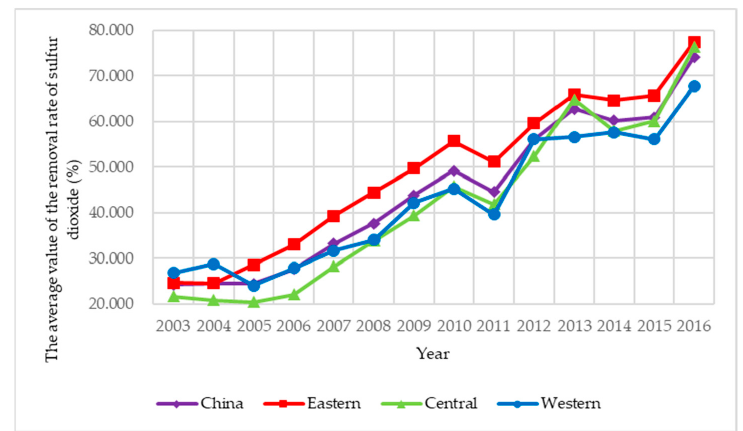
Figure 5. The average value of the removal rate of sulfur dioxide in China during 2003–2016. Int. J. Environ. Res. Public Health 2018 , 15 , x